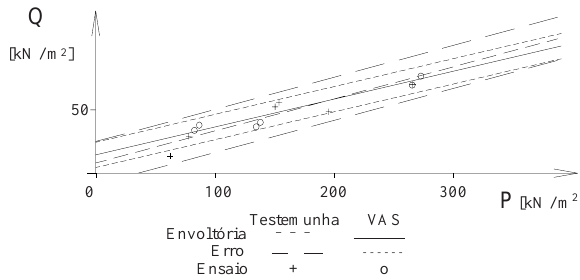
Figura 5. Círculo de Mohr, referente aos ensaios triaxiais para profundidade de trabalho de 0-0,30 m.